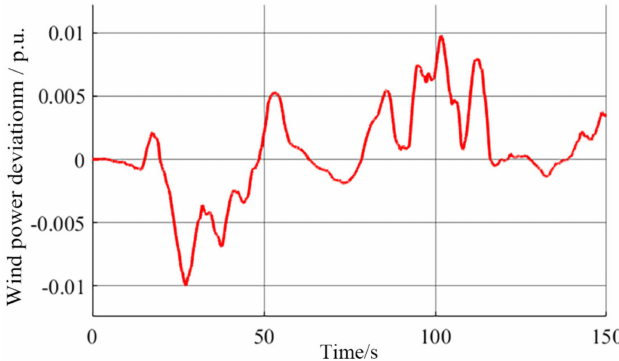
Figure 6. Random power fluctuations in wind farms.